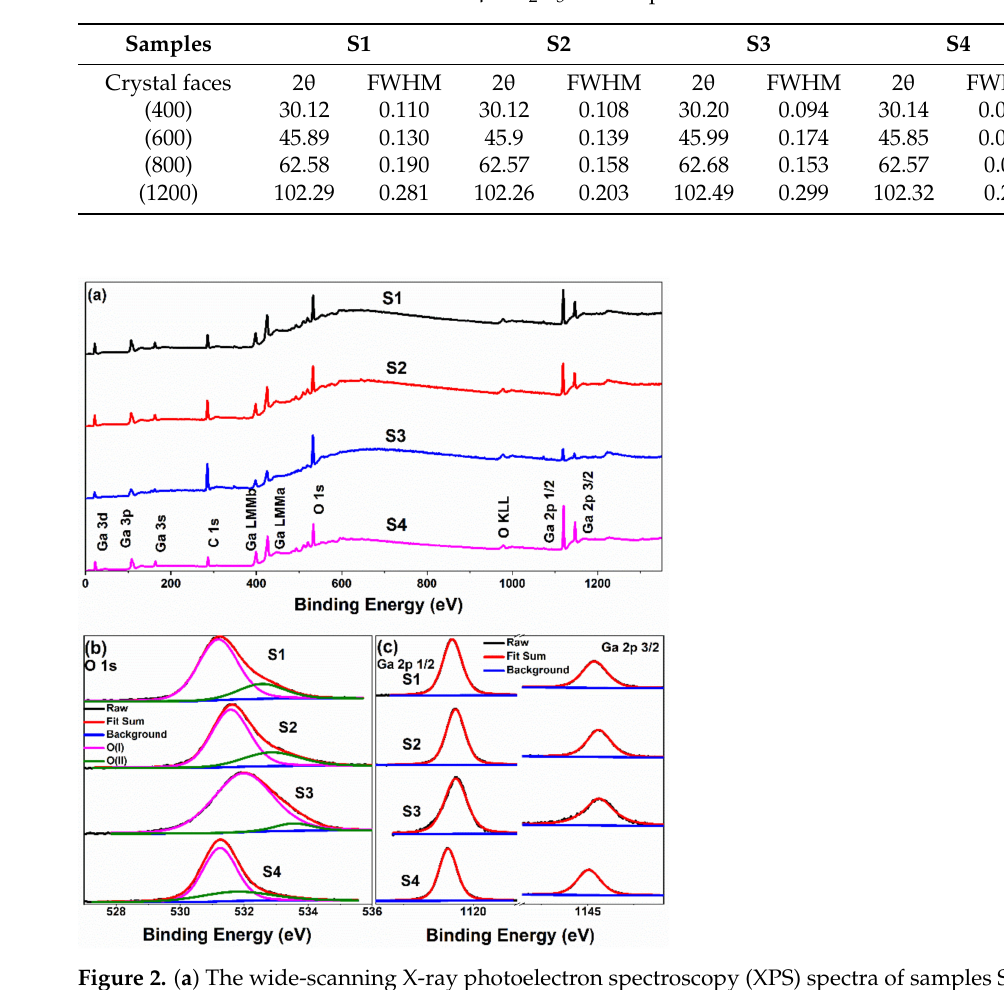
Figure 2. ( a ) The wide-scanning X-ray photoelectron spectroscopy (XPS) spectra of samples S1, S2, S3, S4. ( b ) O 1s fitting results. ( c ) Ga 2p fitting